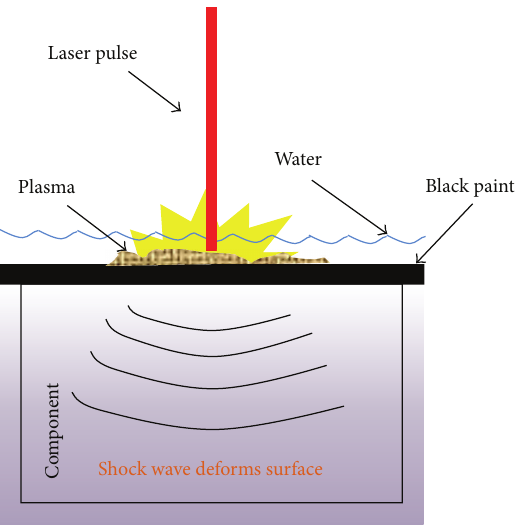
Figure 6: Schematic of the laser peening